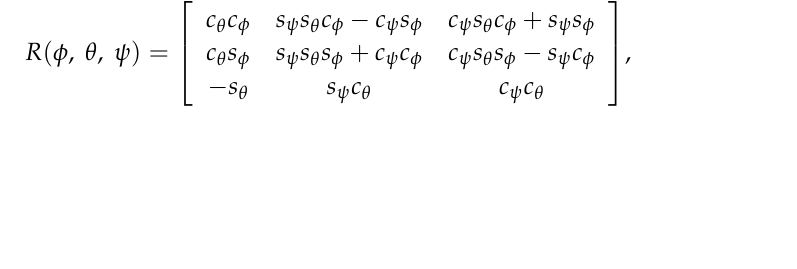
Figure 2. Sensor placement: ( a ) Shows location of joints of robot model along with placement of sensors. Both the physical joints are imaginary. Physical Joint I is located at the hip (hip joint), and Physical Joint II is located on the back (posterior side), just below the neck. Each physical joint has 3-DOF (degree-of-freedom) (three joints are combined to form each Physical Joint) imparting the robot system a total of 6-DOF. Links 1 and 2 are also imaginary and connect Physical Joint I to